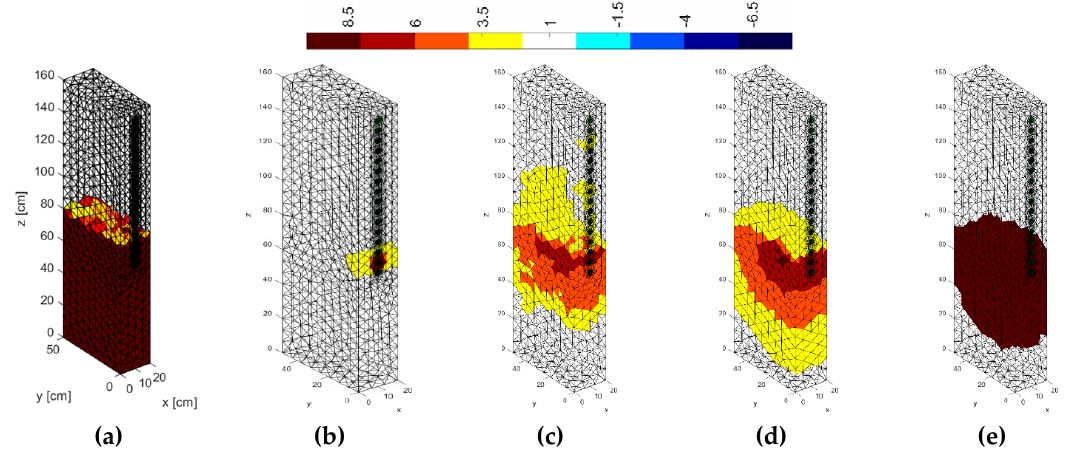
Figure 15. Reconstructions for variant #1: ( a )—Pattern, ( b )—Total Variation, ( c )—LARS, ( d )—Elastic Net, ( e )—ANN.